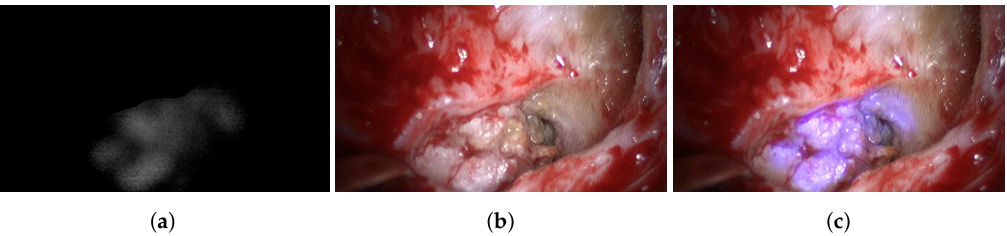
Figure 8. Captured data of Patient #2: ( a ) spectrally segmented cholesteatoma information with λ = 420 nm illumination; ( b ) normal RGB view with broad-band illumination; ( c ) enhanced and augmented spectral RGB view.